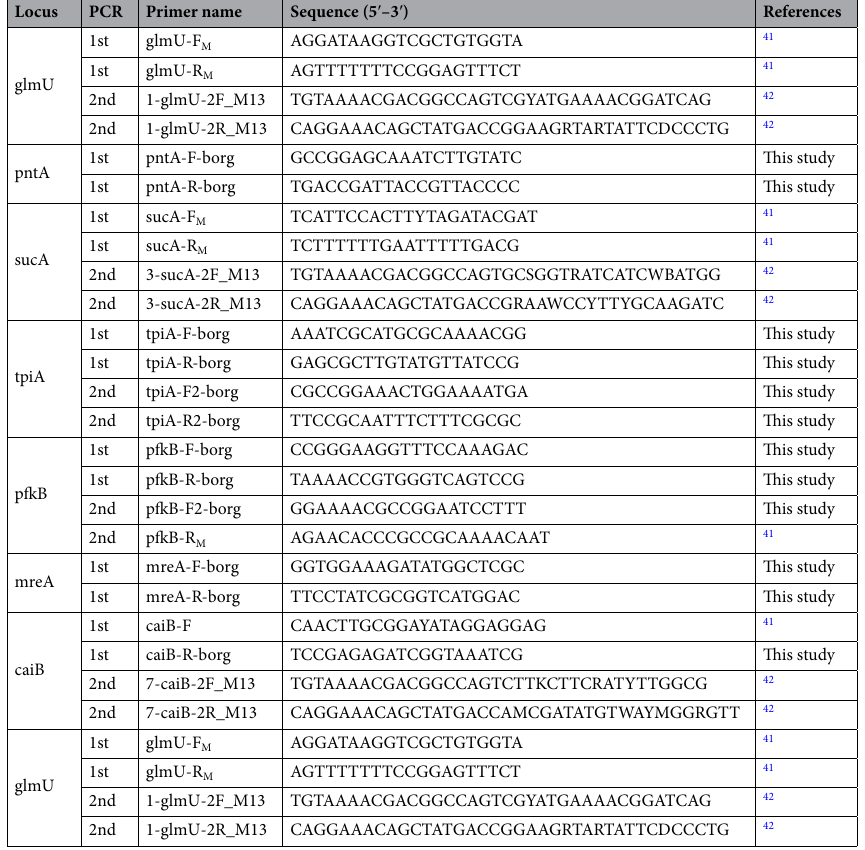
Table 3. MLST primer sets for Leptospira borgpetersenii clone FU18027. MLST, multilocus sequence